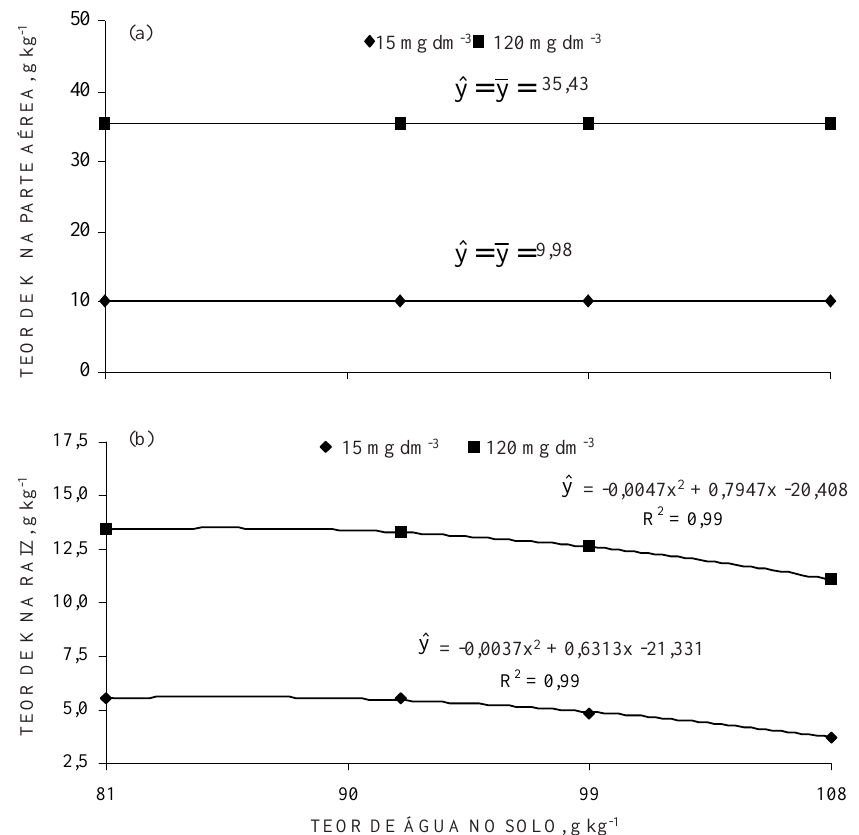
Figura 6. Teor de K (a) na parte aérea e (b) nas raízes do milheto (28 DAE), considerando os teores de água no solo, correspondentes aos potenciais testados, e as doses de potássio. Símbolos = valores observados; linha = valores